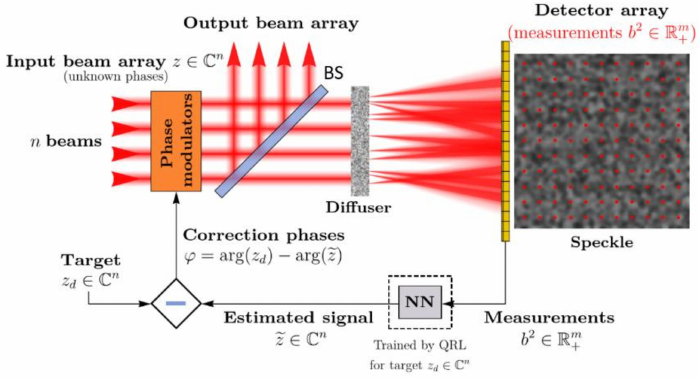
Figure 1. Principle of the system for phase-locking a coherent beam array with a neural network. In a preliminary step, quasi-reinforcement learning (QRL) trains the NN specifically for working in a feedback loop and for setting the array output to a given target phase chart. BS denotes beam